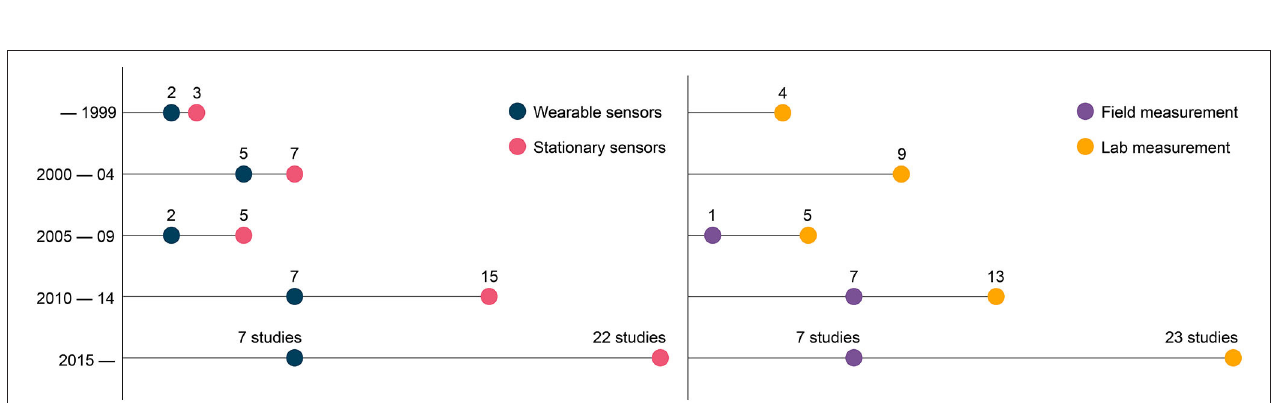
FIGURE 4 | Number of studies utilizing wearable and/or stationary measurement systems and conducting research in lab and/or in field. The number of studies has increased drastically after 2010, yet the number of field studies and of those using wearable sensors has remained low.